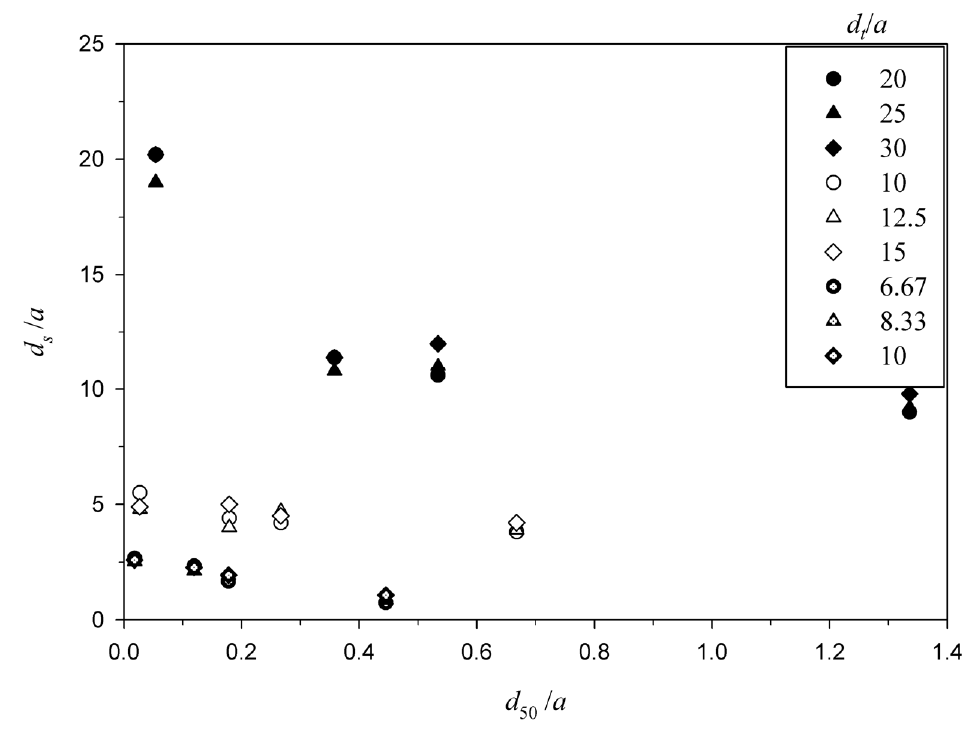
Water 2022 , 14 , x FOR PEER REVIEW Figure 5. d s / a variation with d 50 / a for various a and d t. Figure 5. d s / a variation with d 50 / a for various a and d t .